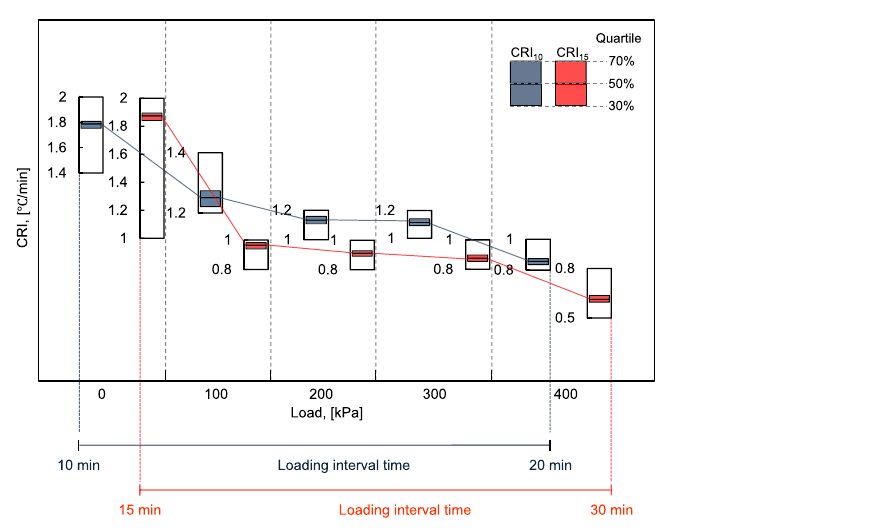
Figure 13. Box plots of CRI10 and CRI15 based on